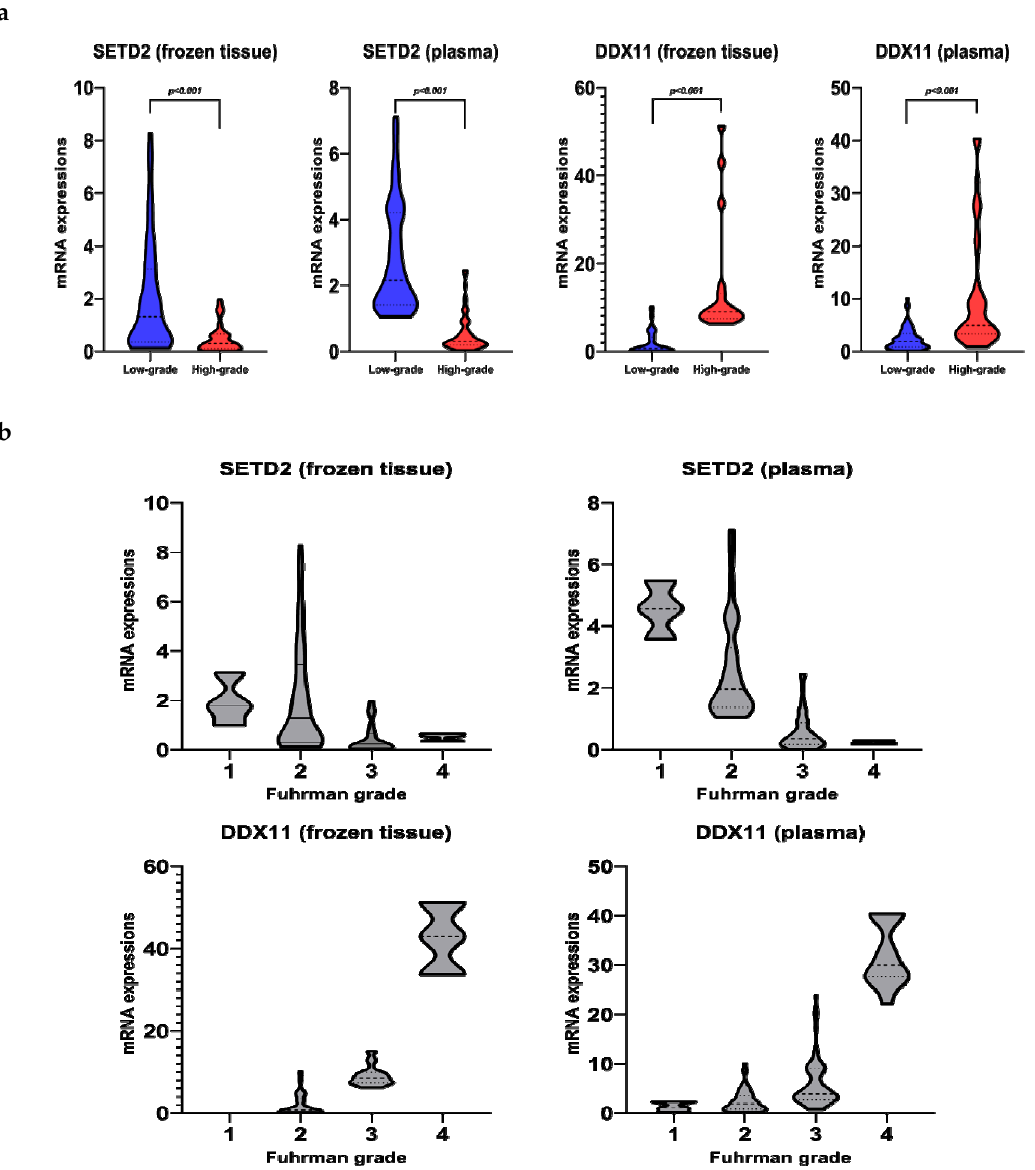
Figure 1. SETD2 and DDX11 mRNA levels in frozen tissue and plasma. ( a ) Low-grade vs. high-grade; ( b ) Fuhrman grades.